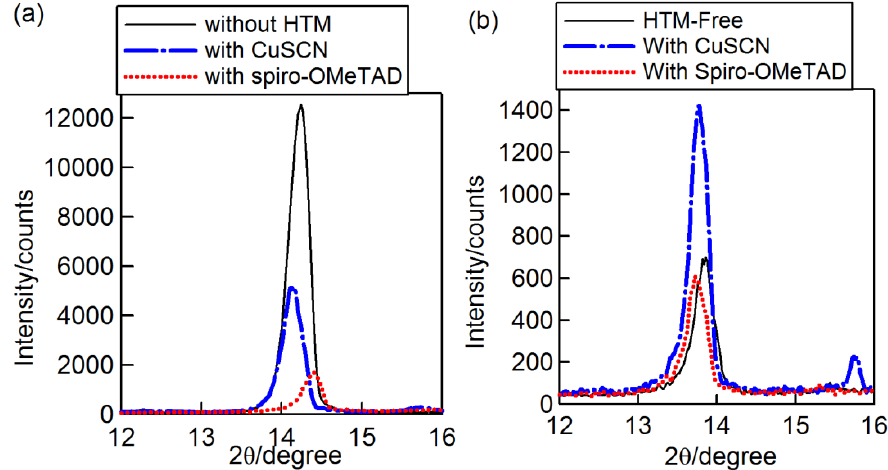
Figure 4. XRD patterns of one-step-processed CH 3 NH 3 PbI 3 perovskite layers with chloride and/or bromide doping, varied by hole-conducting materials (HTM) on the perovskite layer with chloride doping ( a ) and with bromide doping ( b ).